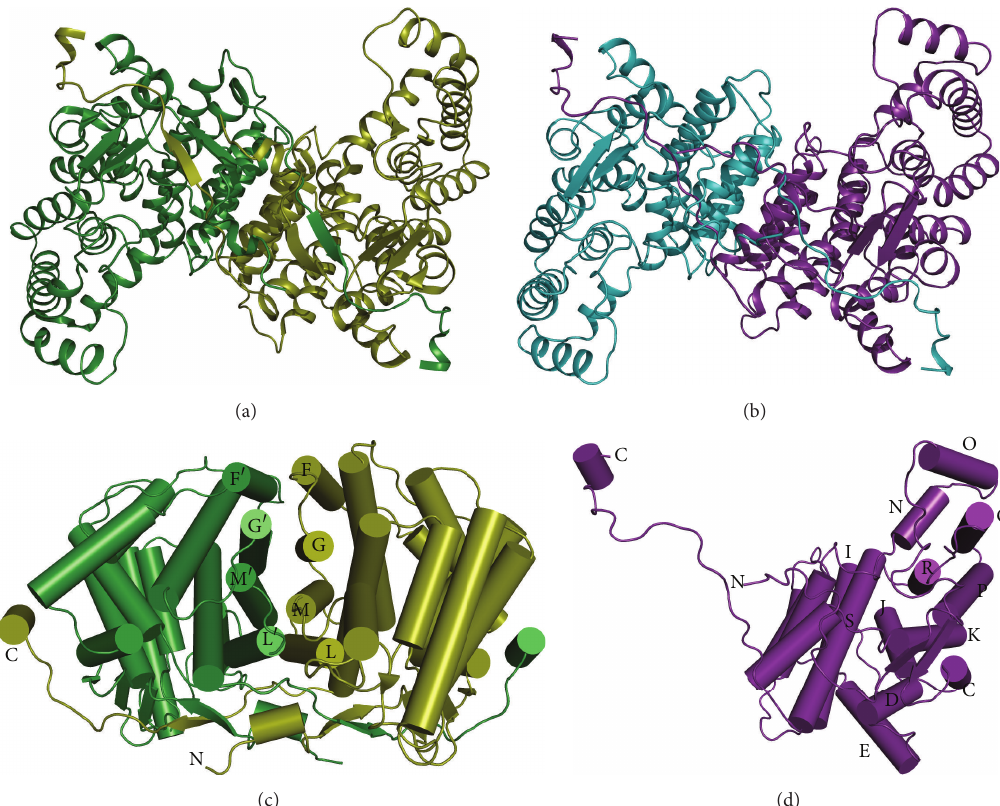
Figure 4: Overview of structures of homodimer of ST-CSs. The view is down a crystallographic 2-fold axis in the crystal of ST0587-CS, which relates the two subunits of the dimer. (a) Structure of ST1805-CS. Polypeptide chains A and B are colored in green and lime, respectively. (b) Structure of ST0587-CS. Each polypeptide is colored in cyan and purple, respectively. Polypeptide chains are shown with a ribbon model. (c) View of the dimer interface of ST1805-CS. (d) View of the monomer of ST0587-CS. Polypeptide chains are shown with a cylinder model.